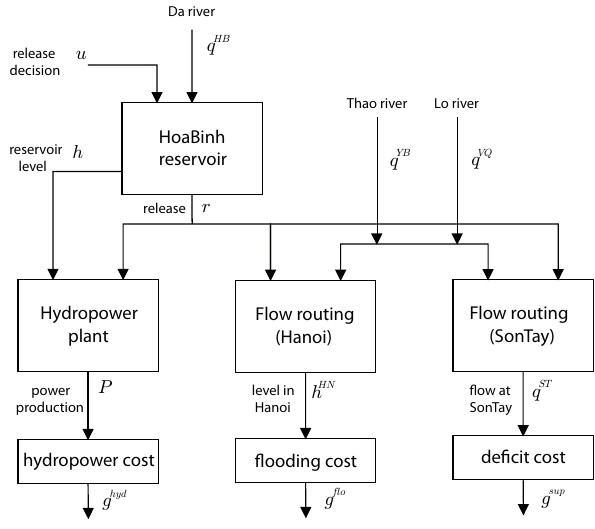
Fig. 2. The model scheme of the Red River Basin and the main system